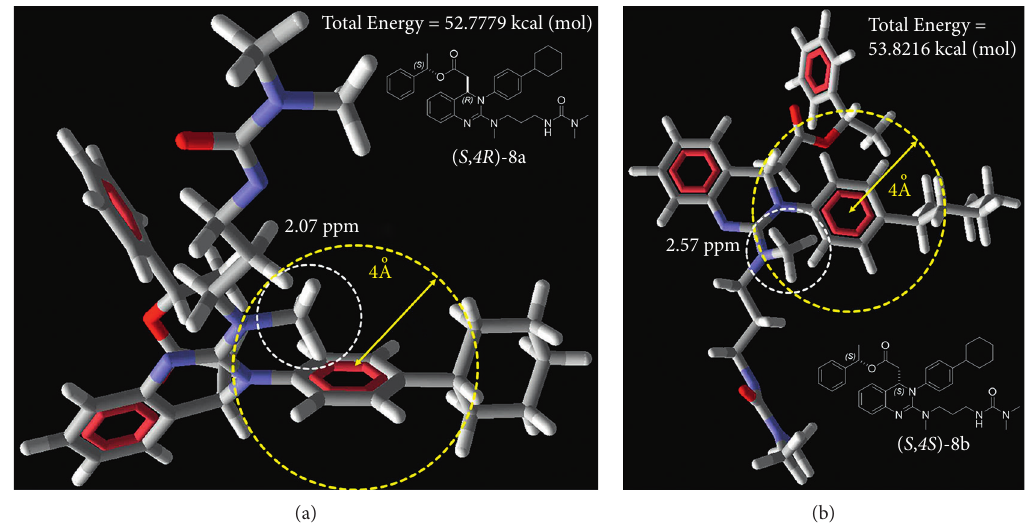
Figure 3: The most stable 3D-conformations of ( S , 4 R )- 8a and ( S , 4 S )- 8b based on molecular mechanics (MM2) calculation. The calculated anisotropic effect zone of the benzene ring was represented by yellow-colored dotted circle (radius 4 ˚A: Δ δ � 0.5 ppm) according to the reported literature [21]. The chemical shifts of N -methyl groups inside white yellow-colored dotted circles in ( S , 4 R )- 8a (a) and ( S , 4 S )- 8b (b) exhibited 2.07 and 2.57ppm.